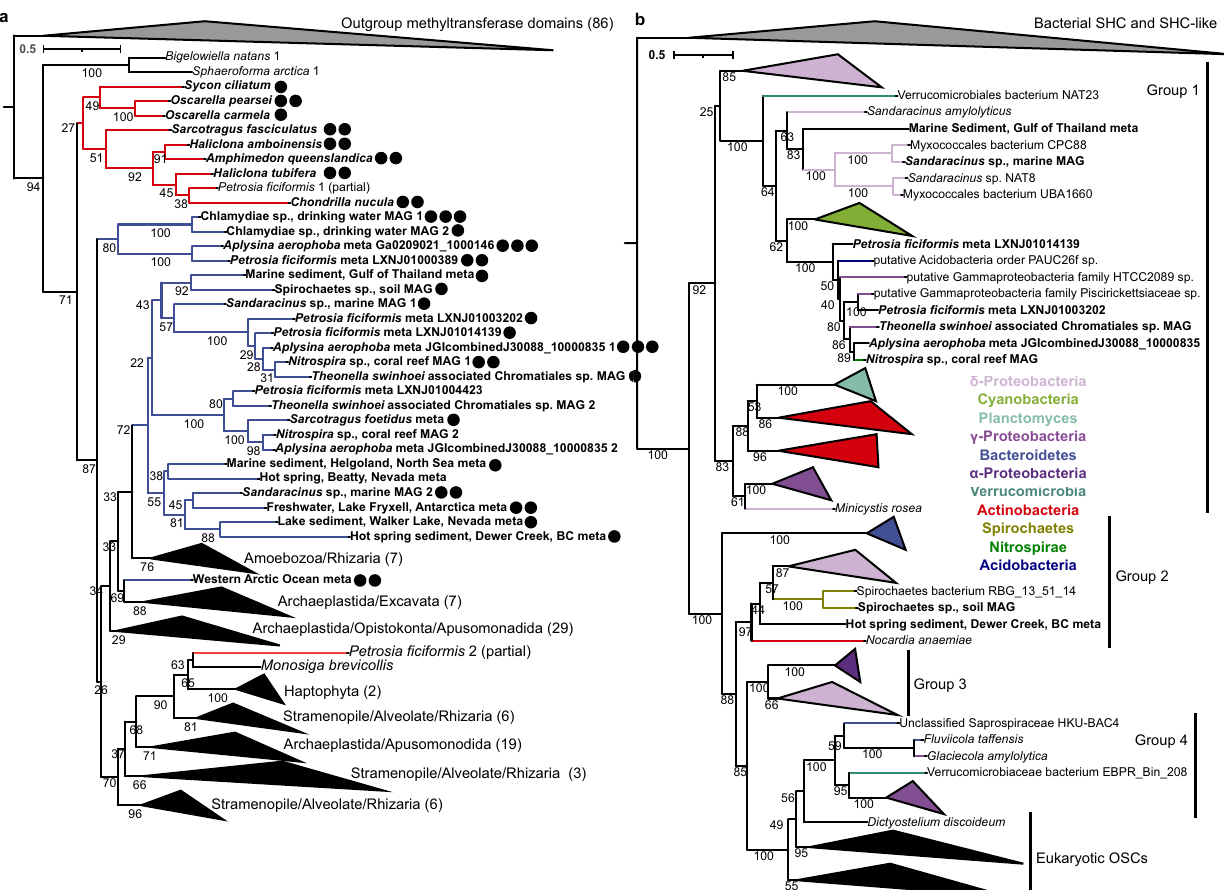
Fig. 4 | Functional metagenomic SMTs are bacterial. a Maximum likelihood tree generated from aconcatenatedalignment of the conservedmethyltransferase and C-terminal domains of sterol methyltransferase (SMT) proteins. Metagenomic SMTs are in blue, sponge SMTs are in red, and other eukaryotic SMTs are in black. Bolded labels indicate SMTs tested in this study, and the number of circles